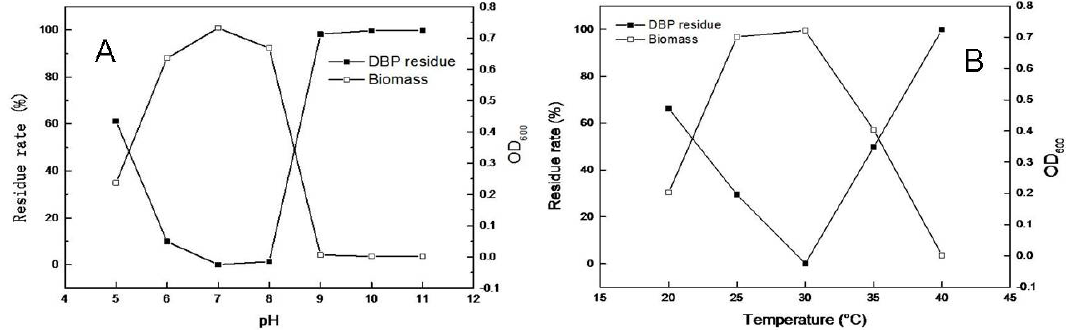
Figure 3. Effects of pH and temperature on strain TJ biomass and DBP biodegradation.